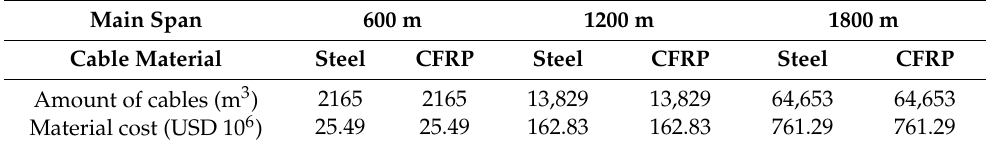
Table 5. Amount and cost of steel used for girders.